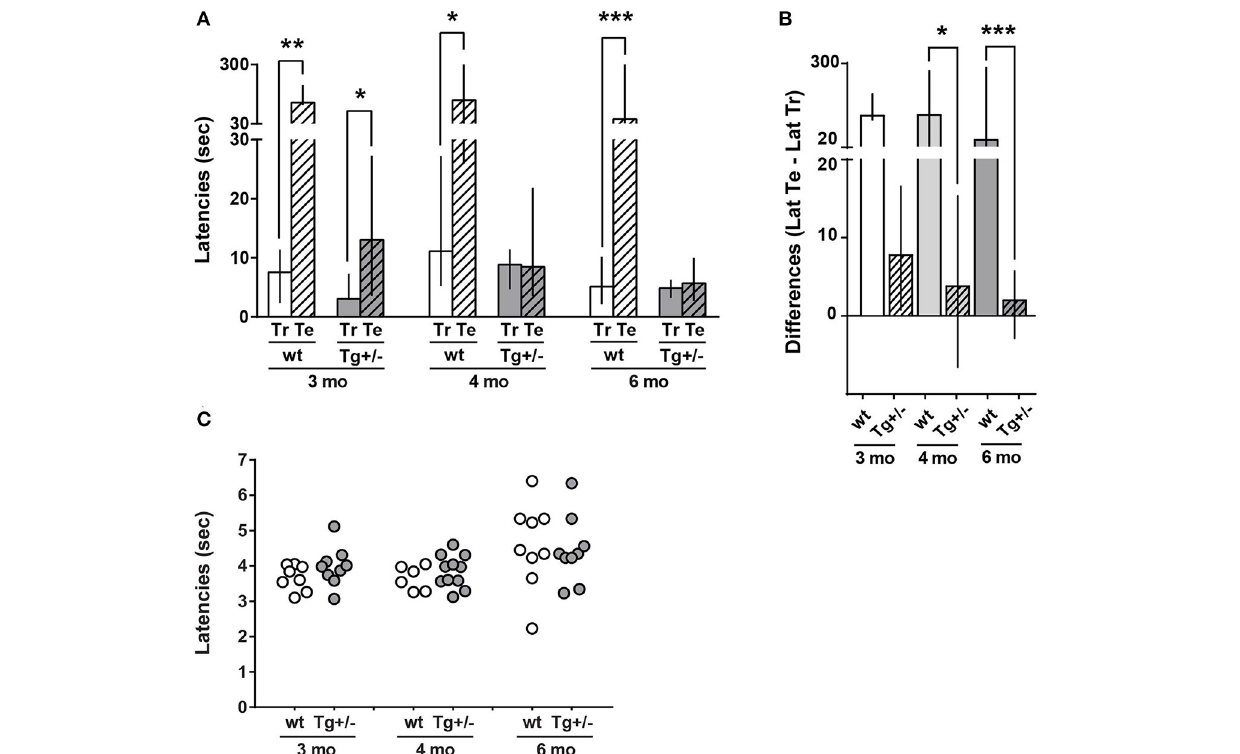
FIGURE 2 | Long-term memory (LTM) of inhibitory avoidance (IA) in 3-, 4-, and 6-month-old McGill-R-Thy1-APP Tg + /– rats. (A) IA task: Training and Test Latencies. Tg + /– (dark gray bars) and wt littermates (white bars) were trained in a step through IA to a mild foot-shock (0.5mA) and tested 24h later. Latencies to enter the dark compartment (from a lighted one) were recorded. The bar diagram represents median of latencies and interquartile ranges (25;75). Test latencies (Te, stripped bars) to enter the dark compartment were significantly higher than training latencies (Tr, plain bars) for 3, 4, and 6-month-old wt rats. However, only 3-month-old Tg + /– rats showed a significant difference between Te and Tr latencies. Neither 4- nor 6-month-old Tg rats showed differences between Te and Tr latencies. Significant differences were assessed by Wilcoxon matched pairs signed rank test; * P < 0.05, ** P < 0.01, *** P < 0.001. (B) . IA task: (Te – Tr) Latencies Difference. Bar diagram represents median of (Te-Tr) difference of latencies, with interquartile ranges (25;75) for the same groups as in A. Differences were significantly lower in Tg + /– (stripped bars) than in wt (plain bars) rats of 4 (light gray) and 6 (dark gray) months, whilst there were no statistically significant differences among the difference of latencies by genotype in 3-month-old rats (Unmatched Kruskal-Wallis test with Dunn’s multiple comparisons. * P < 0.05, *** P < 0.001). Tt-Tr latency difference of 3-month-old Tg + /– rats was significantly different form zero, while latency differences for 4- and 6-month-old Tg + /– rats were not different from zero. Unmatched Kruskal-Wallis test with Dunn’s multiple comparisons. * P < 0.05) (3 mo: N wt = 8, N Tg + / − = 7; 4 mo: N wt = 7, N Tg + / − = 11; 6 mo: N wt = 11, N Tg + / − = 13). (C) Tail-Flick latency. Tail withdrawal latency from a hot (51 ± 1 ◦ C) water bath is represented in the scatter plot. No significant differences were observed between any selected pair of animals (Tg or wt) of a given age (Unpaired Mann-Whitney